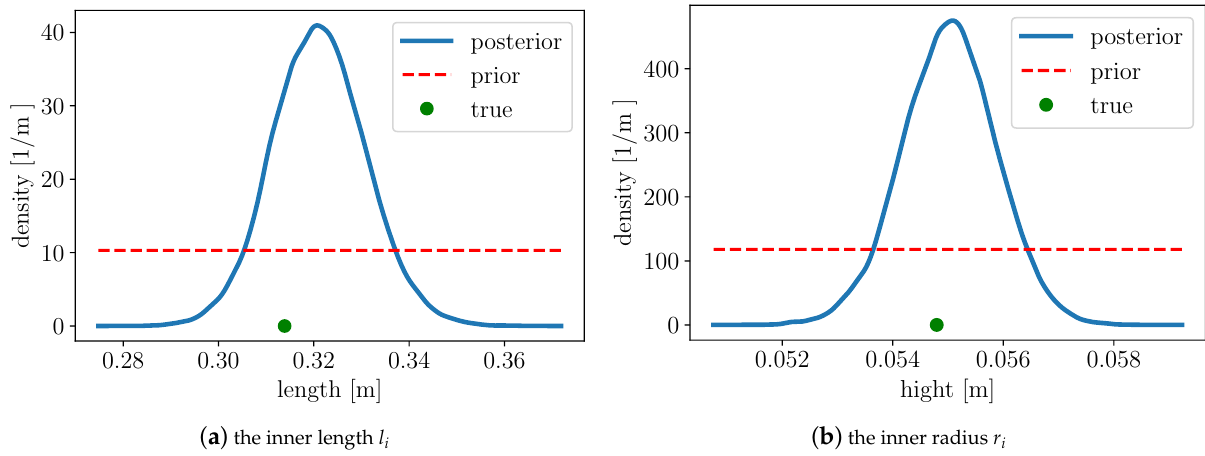
Figure 9. The estimated posterior density function of the inner dimensions θ “ r l i , r i s . The sold line is the posterior PDF, the dotted line is the prior PDF and the bullet dot represents the true value l i “ 0.313 m and r i “ 0.055